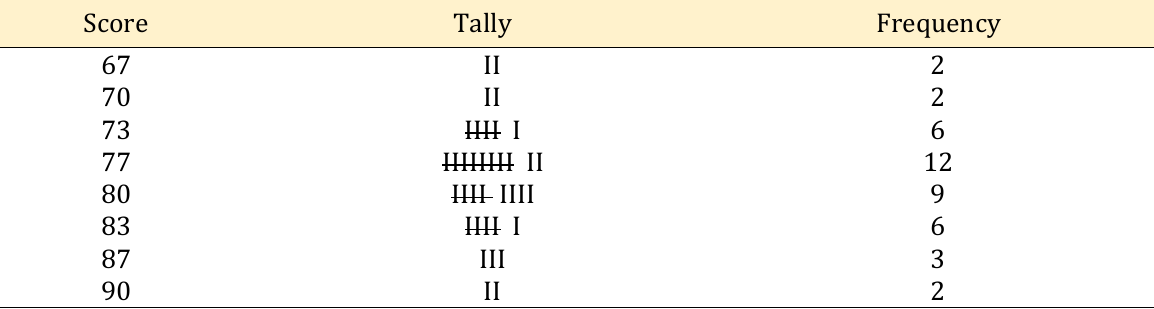
Table 4: Tally of the Students' daily score in